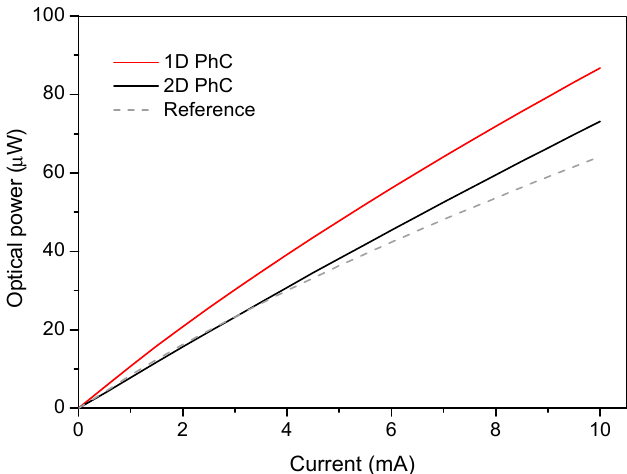
Figure 9. L(I ) dependence of LEDs with 1D PhC and 2D PhC structures compared with reference LED.